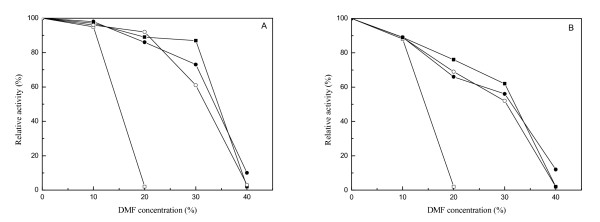
Effects of solvents on native and modified CPOs at 30°C for 1 h. A: peroxidase activity; B: Sulfoxidation activity. CPO (∀); CA-CPO (,); MA-CPO (!); PA-CPO (○). The values represent the mean of three independent sets of experiments with SD < 5%.